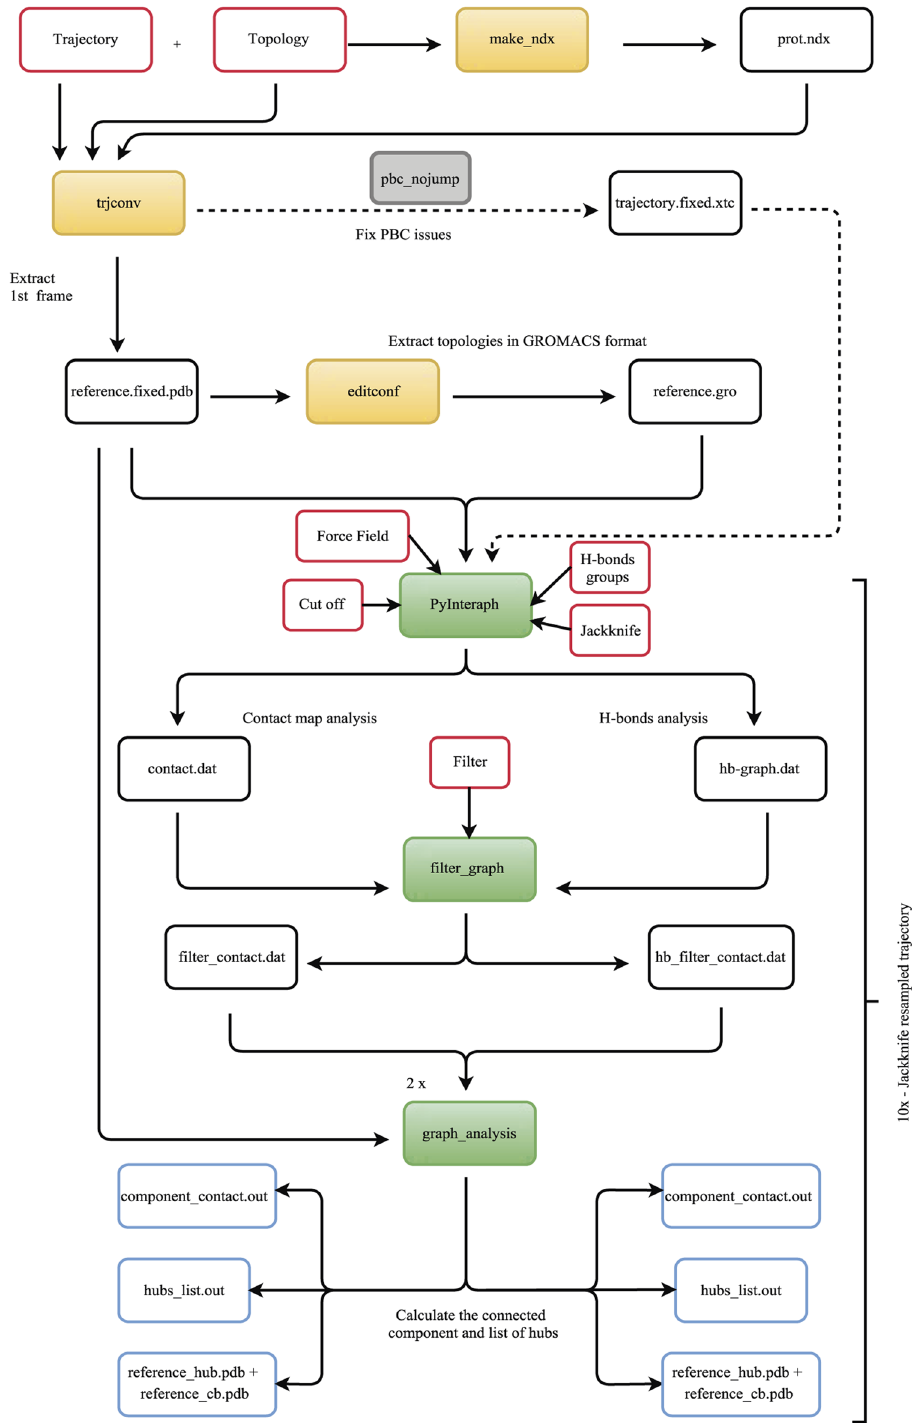
Figure 8. Flow chart for the PyInKnife pipeline for PSN analyses. The orange boxes represent the tools used from GROMACS software ( make_ndx : to generate an index file consisting of the groups of interest, trjconv : to convert and manipulate trajectory files and editconf : to convert and manipulate structure files). White boxes with the red border are the main inputs of the pipeline while the boxes with blue border are the main outputs. An optional flag has been added to post-process the MD trajectories to remove artefacts related to periodic boundary conditions with trjconv (grey box). The green boxes represent the commands used from PyInteraph . The inputs required for the PyInteraph tool are the force field used in the MD simulation, the selected distance cutoff and the optional usage of the Jackknife resampling method. Moreover, the user can choose if to include or not the H-bonds in the PSN analysis. As an input, it is also possible to change the p crit cutoff value used to remove the less informative interactions; by default this value is set to